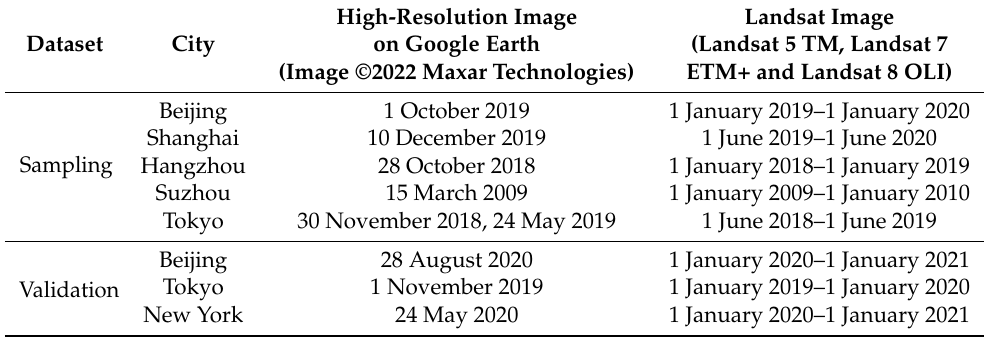
Table 1. Acquisition times of images for sampling and